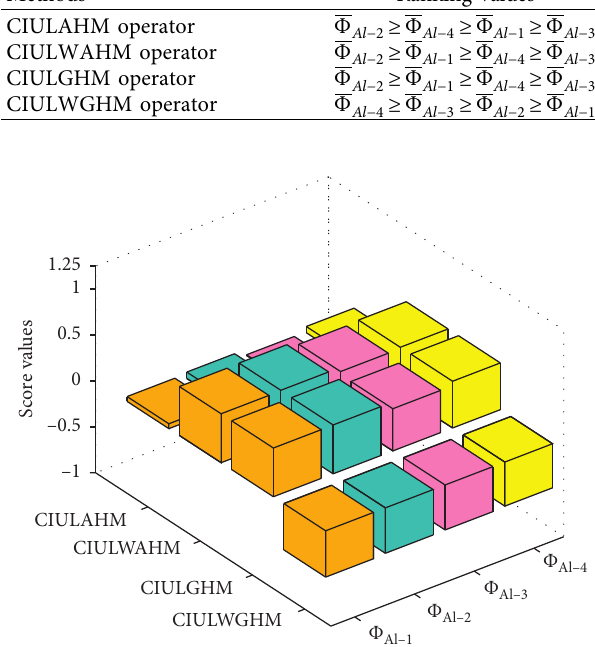
Figure 3: Geometrical interpretation of the information given in Table